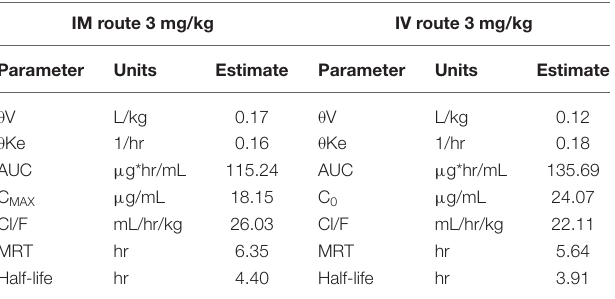
TABLE 1 | Population pharmacokinetic data for ketoprofen injected in trout at a dose of 3 mg/kg, IV or IM.